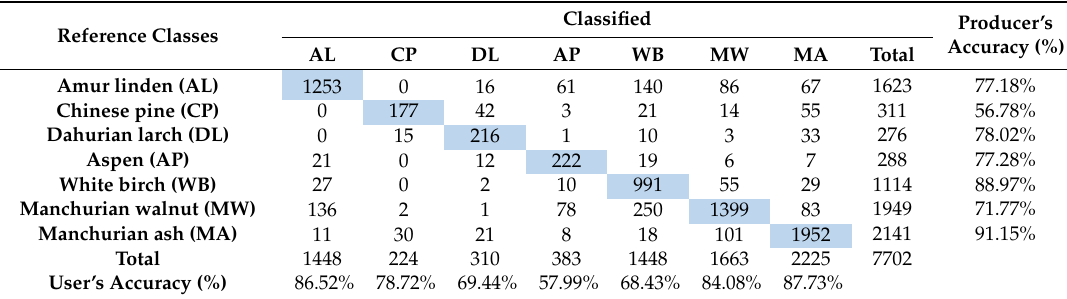
Table 4. Confusion matrix of the test set by the RF